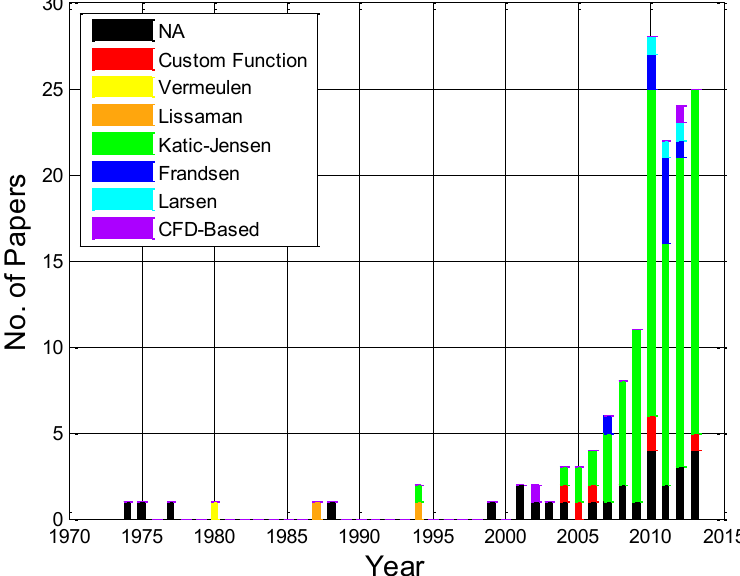
Figure 3. Timeline of Wake Models used in the WFDO